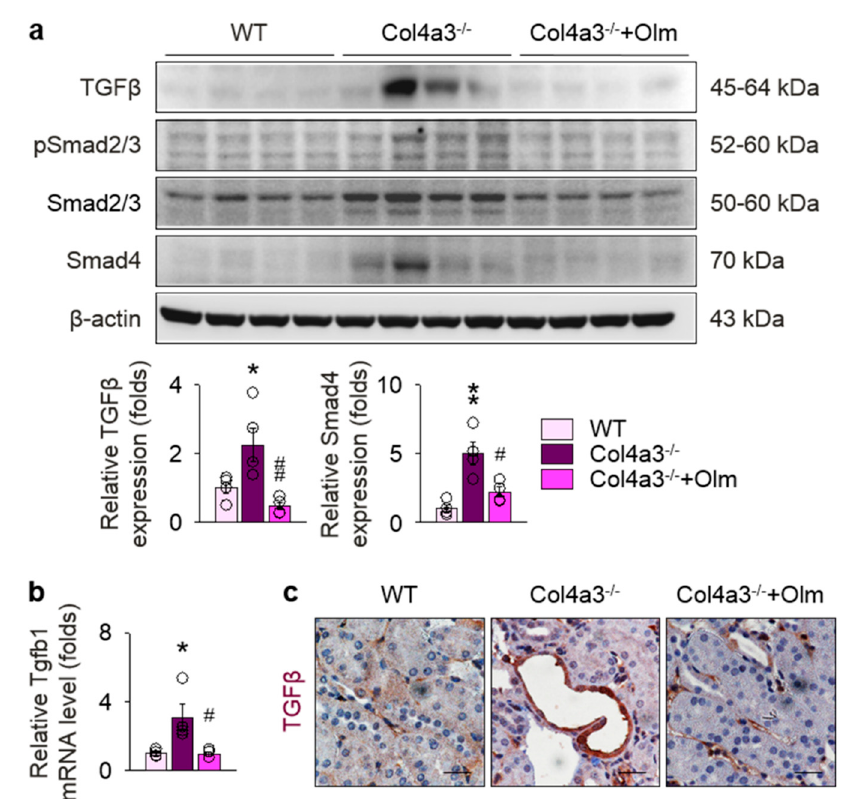
Figure 2. Upregulation of TGF β and activation of its downstreams in Col4a3 – / – mice is attenuated by olmesartan. ( a ) Comparison of protein expression level TGF β and its downstream determined by immunoblotting from the kidney of WT, Col4a3 – / – , and Col4a3 - / - + Olm mice ( n = 4 mice / group). β -actin was used as the endogenous control. ( b ) Comparison of mRNA expression-level TGF β 1 determined by qPCR from the kidney WT, Col4a3 – / – , and Col4a3 - / - + Olm mice ( n = 4 mice / group). β -actin was used as the endogenous control. ( c ) Representative images of immunohistochemical staining for TGF β in the renal cortex of WT, Col4a3 – / – , and Col4a3 - / - + Olm mice. Scale bars, 50 µ m. * P < 0.05, ** P < 0.01 versus WT mice; # P < 0.05, ## P < 0.01 versus Col4a3 – / – mice by one-way ANOVA with Newman–Keuls multiple comparison test.